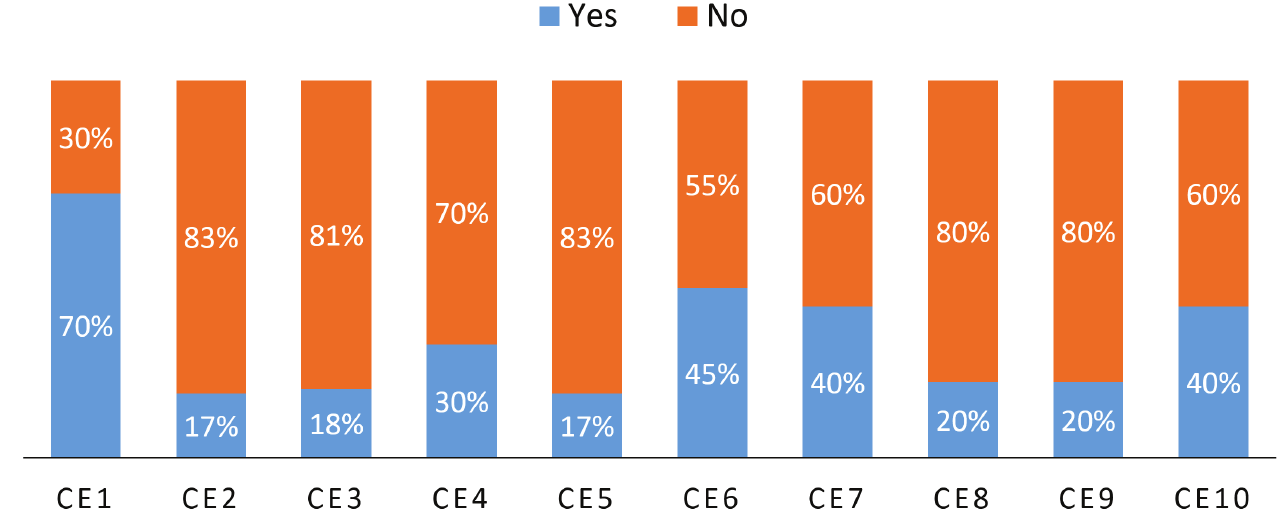
Figure 2. CE indicator